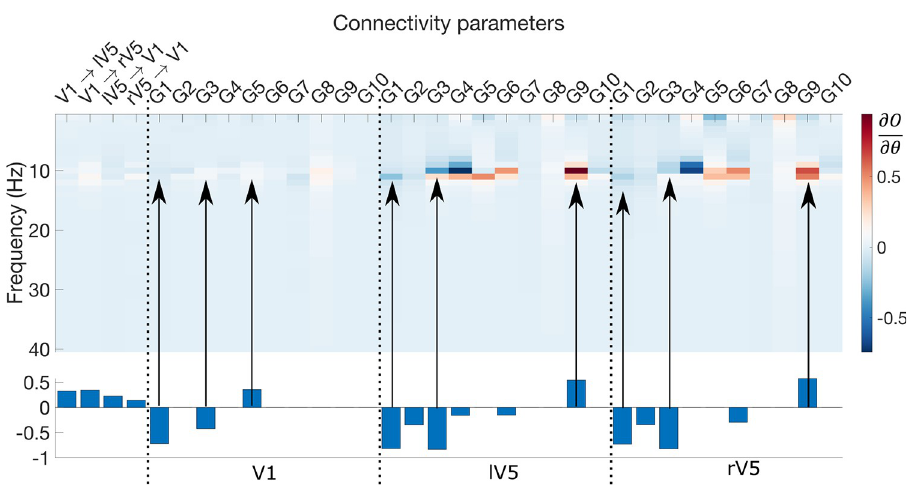
Fig 6. Sensitivity analysis. The results of the sensitivity analysis—averaged across subjects—are shown in image format. The group BMA results (i.e. the middle panels of Figs 4 and 5 ) are provided in the lower part for comparison. Simply put, positive (red) values indicate that an increase of a parameter at the posterior mean would result in increased power at that specific frequency bin. A negative value (in blue) means an increase of a particular parameter results in a decreased power. The arrows indicate the sensitivities for the significant intrinsic connectivity modulations that are shown in the lower part of the figure. @ O is the Jacobian of the power spectrum of the generative model with @ y respect to the model parameters of interest (intrinsic and extrinsic) which are shown for all modelled frequency bins.